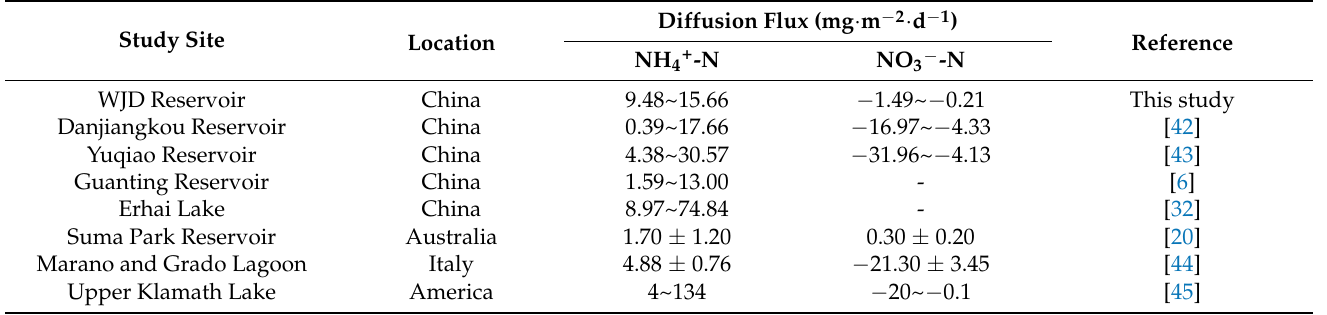
Table 6. Comparison of inorganic nitrogen diffusion fluxes at the SWI of other